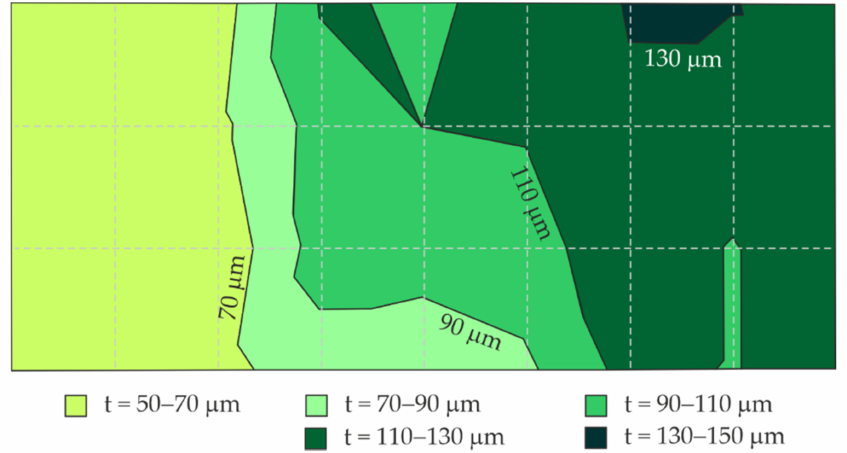
Figure 10. Map of thickness distribution of blue coating on the large steel sheet based on measure- ments with the